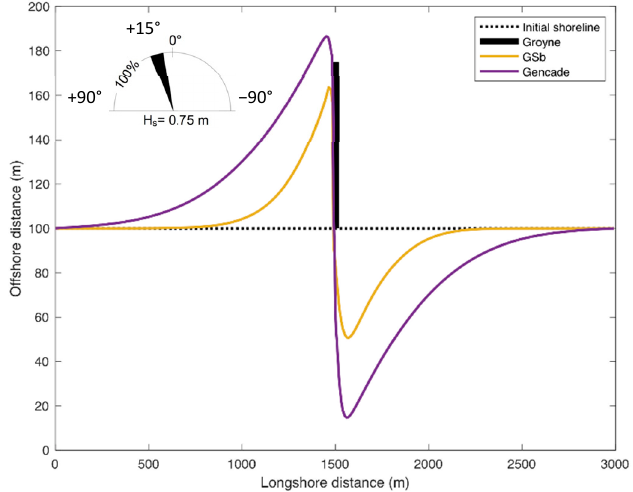
Figure 4. Comparison between GSb and GENCADE.